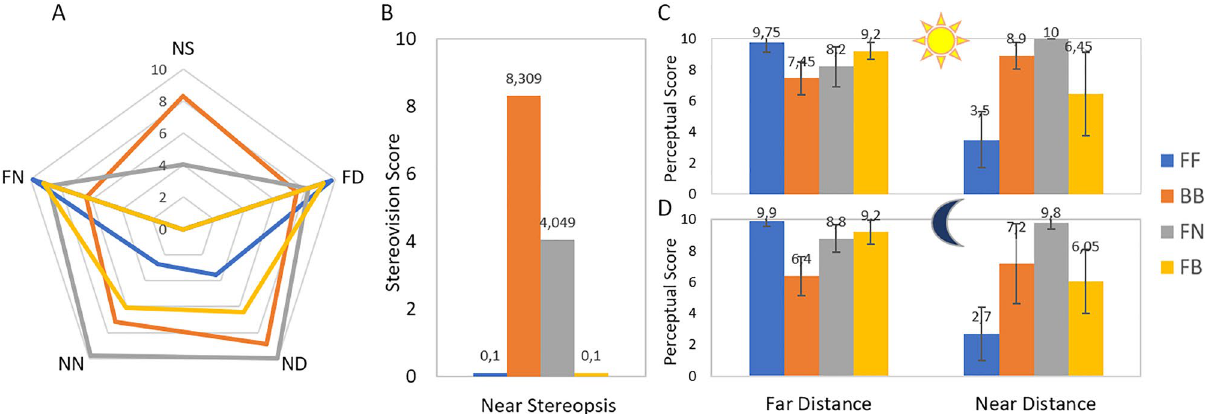
Figure 3. MAS-2EV polygons, near stereovision and perceptual scores for subject S1_SV, with presbyopic corrections simulated with SimVis. ( A ) MAS-2EV polygon. The upper vertices represent stereopsis score (NS), and the four lower vertices perceptual scores for far-day (FD), near-day (ND), near-night (NN) and far-night (FN) counter-clockwise. ( B ) Near stereovision scores. (C and D) Perceptual scores (PS) for far distance (left columns) and near distance (right columns), for day stimuli (upper graph) and night stimuli (lower graph) for the different corrections. In all graphs Blue stands for both eyes corrected for far (FF); Orange both eyes corrected with bifocal lenses (+ 2.50 D add, BB); Gray stands for monovision (monofocal for far distance in the dominant eye and + 2.50 D monofocal in the non-dominant eye, FN); Yellow stands for modified monovision (monofocal for far distance in the dominant eye and bifocal lens with + 2.50 D near add in the non-dominant eye, FB). Each data point is the average across 10 repeated measurements, and error bars represent standard